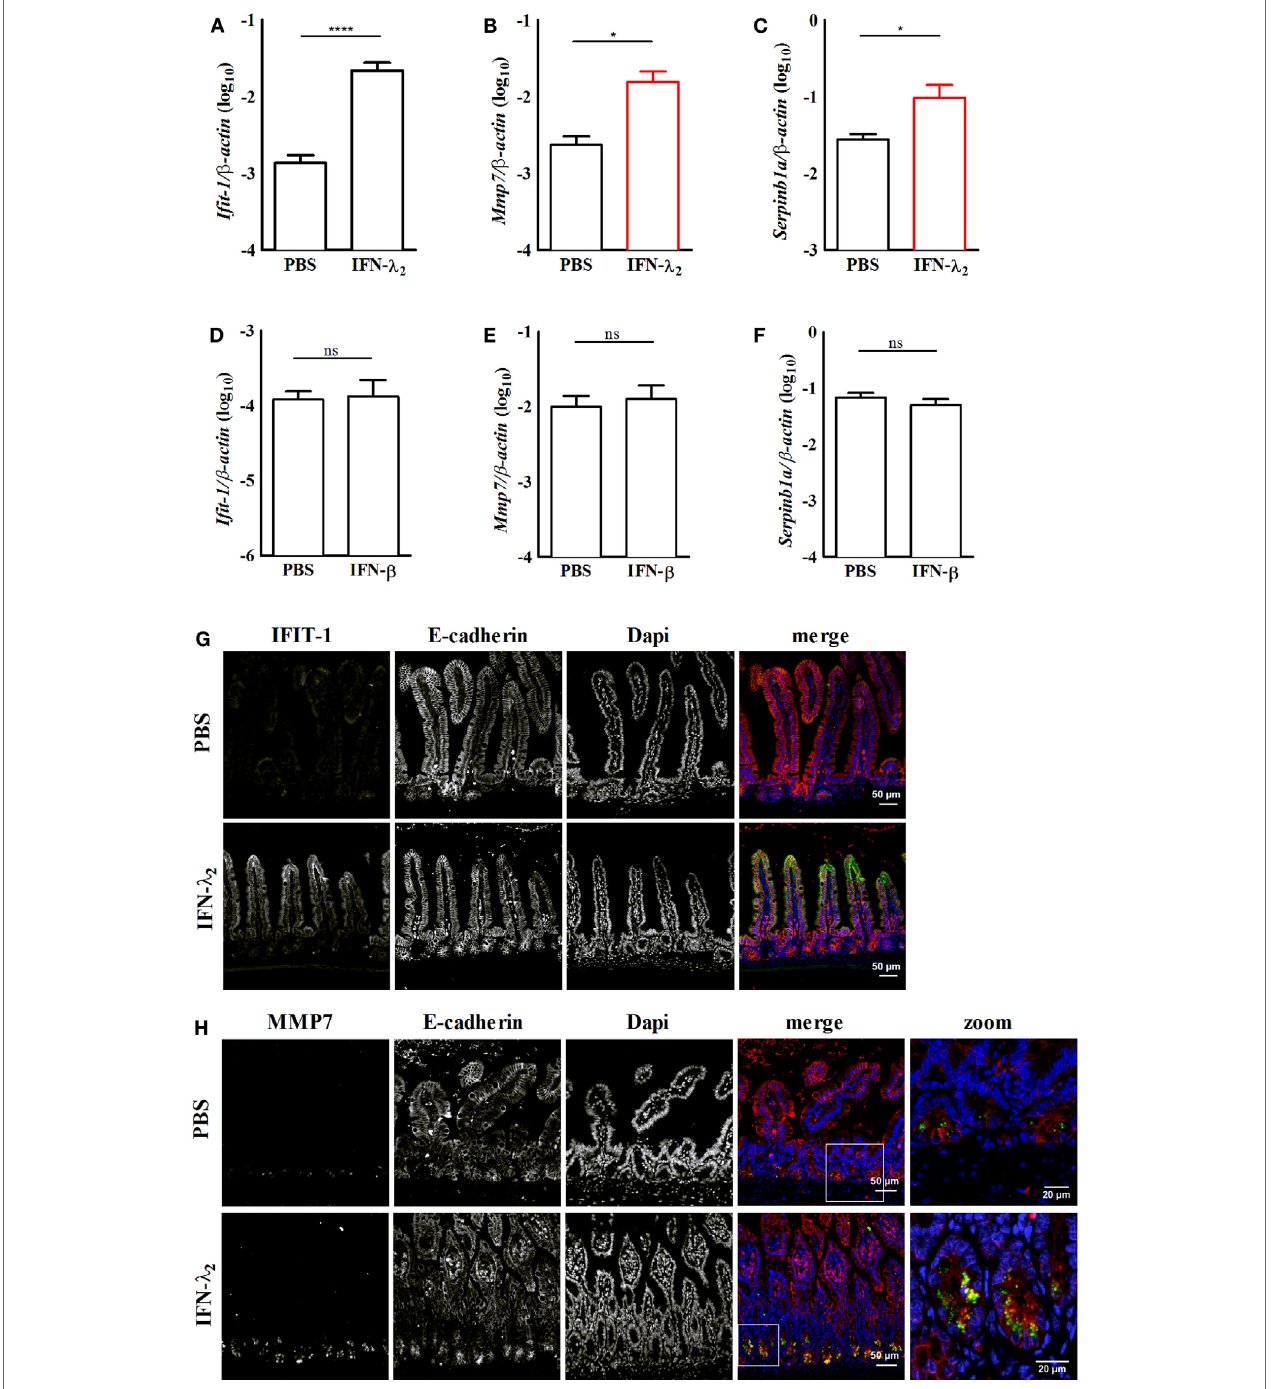
FigUre 4 | In vivo confirmation of the expression of predominantly interferon (IFN)- λ 2 -induced genes in the intestinal epithelium. Primary intestinal epithelial cells were isolated from IFNAR1 − / − (a–c) or IL28R − / − (D–F) female 8-week-old adult mice 9 h after intraperitoneal injection of IFN- λ 2 [1 µg, (a) ] or IFN- β [500 U, (D) ], respectively. Control animals in each group received PBS. Quantitative RT-PCR for the prototypical IFN-stimulated gene (ISG) Ifit1 [ (a) , n = 12 animals per group; (D) , n = 8 animals per group], the predominantly IFN- λ 2 -induced ISGs Mmp7 [ (b) , n = 8 animals per group; (e) , 8 animals per group] and Serpinb1a [ (c) , n = 12 animals per group; (F) , 8 animals per group] performed on total RNA prepared from primary intestinal epithelial cells. Epithelial cells were isolated from PBS or IFN- λ 2 treated IFNAR1 − / − mice or PBS or IFN- β treated IL28R − / − animals. The results are normalized to β -actin and are represented as mean ± SEM from two to three independent experiments. Statistical analysis was performed using the Mann–Whitney U test. (g,h) Paraffin-embedded samples from IFNAR1 − / − mice treated with PBS or IFN- λ 2 as indicated were subjected to simultaneous staining for (g) IFIT1 (green) and E-cadherin (red) or for (h) MMP7 (green) and E-cadherin (red). Counterstaining was performed with DAPI (blue). White squares depict the zoomed area of the merged images in panel (h) . Scale 50 and 20 µm in the zoomed areas.